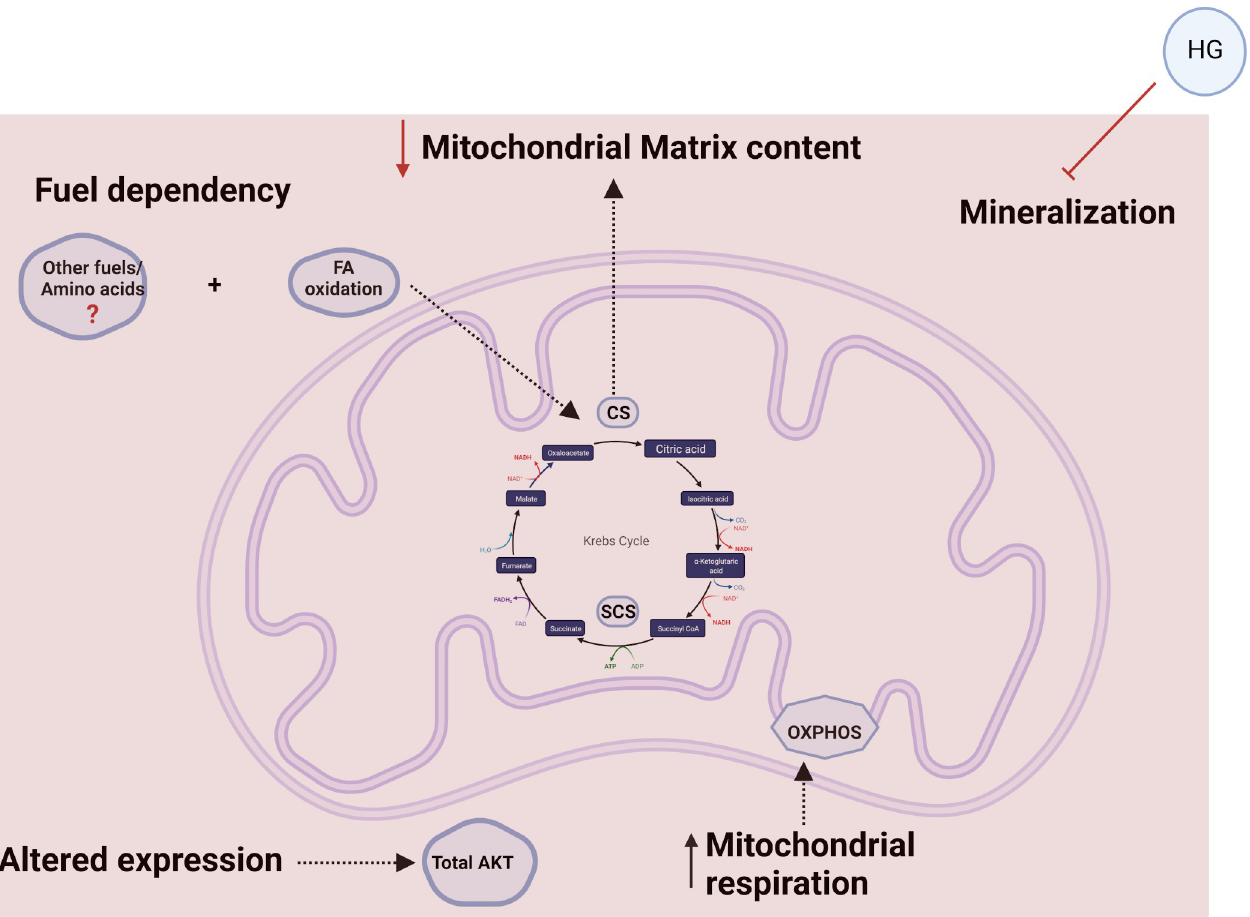
Fig 7. HG-treated osteoblast cells exhibit inhibited mineralization and changes in bioenergetic needs as a result of hyperglycemia inhibiting osteoblast differentiation. Accumulation of calcium was inhibited due to high glucose treatment. Total AKT expression was reduced as well. High glucose treatment promoted mitochondrial perturbations by altering expression of SCS subunits in the TCA cycle and reduction in mitochondrial matrix content via decrease of CS activity. Differentiated osteoblasts under hyperglycemic conditions utilize both mitochondrial respiration and glycolysis similarly to what is seen in early stages of differentiation suggesting that excess of glucose promotes shifts in metabolic needs with preference for mitochondrial respiration. HG-treated osteoblast cells rely on fatty acid to maintain baseline energy demands, but it seems other pathways are required in HG conditions. Molecules and metabolic pathways altered under high glucose conditions are depicted in light blue. � Figure was created by BioRender.com.